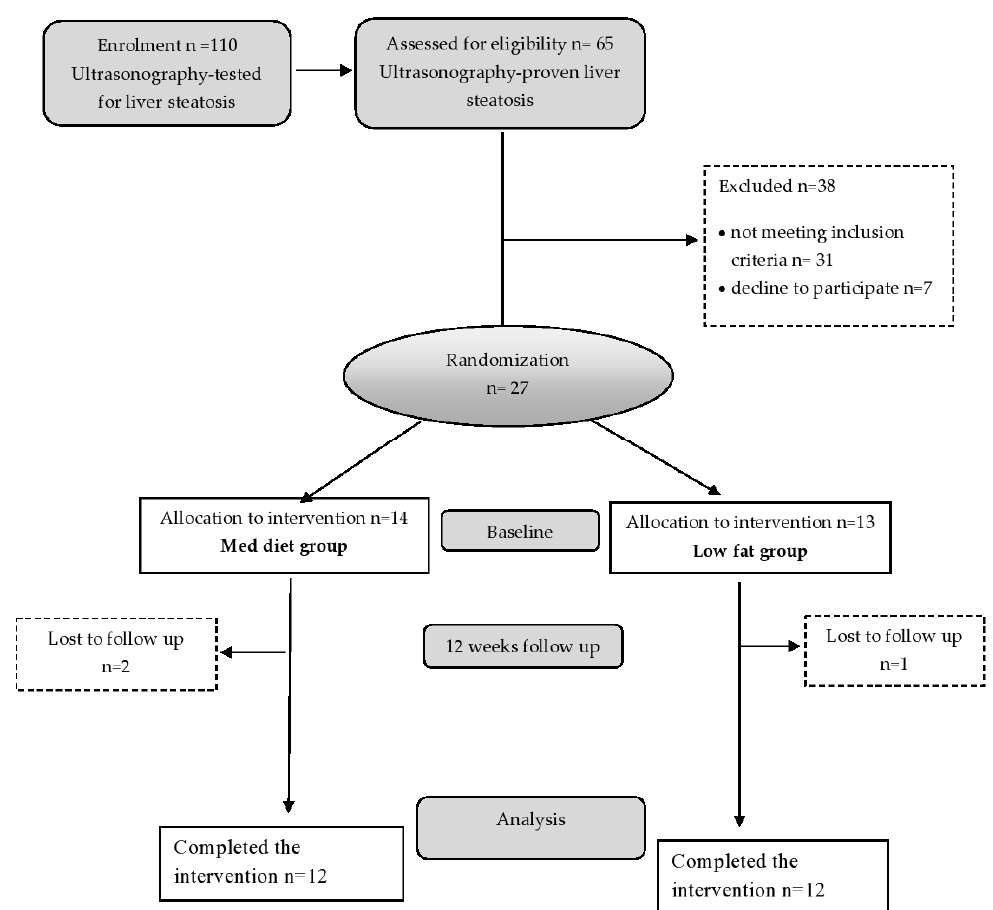
Figure 1. Flow chart of the study participants.